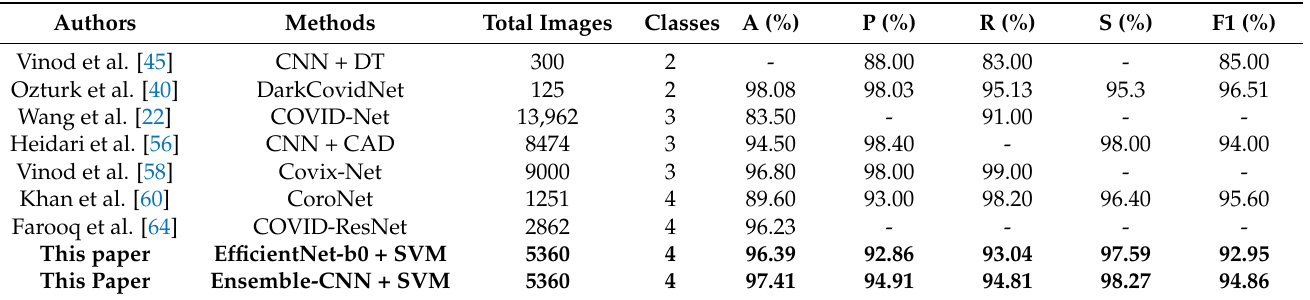
Table 7. Comparison of recently published studies on COVID-19 detection from CXR images 1